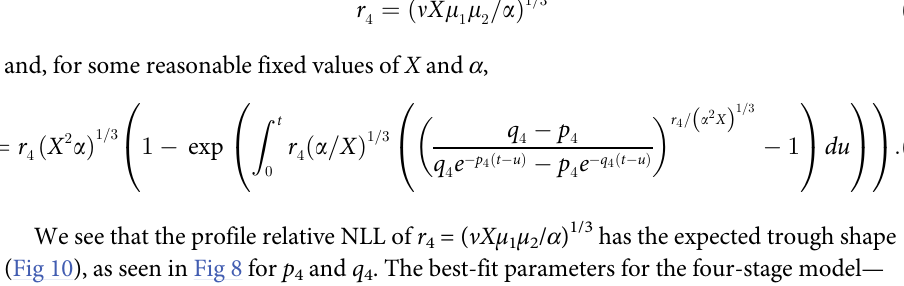
Fig 7. Profile likelihood for the reparameterized combination of the three-stage model. Profile of the relativenegative log-likelihood (NLL) as the parameter r parameters are fit in the three-stage clonal expansionmodel. The gray dotted line gives the α = 0.01 threshold for simultaneous confidenceintervals basedon the relative negativelog-likelihood. Parameter combination r 3 is